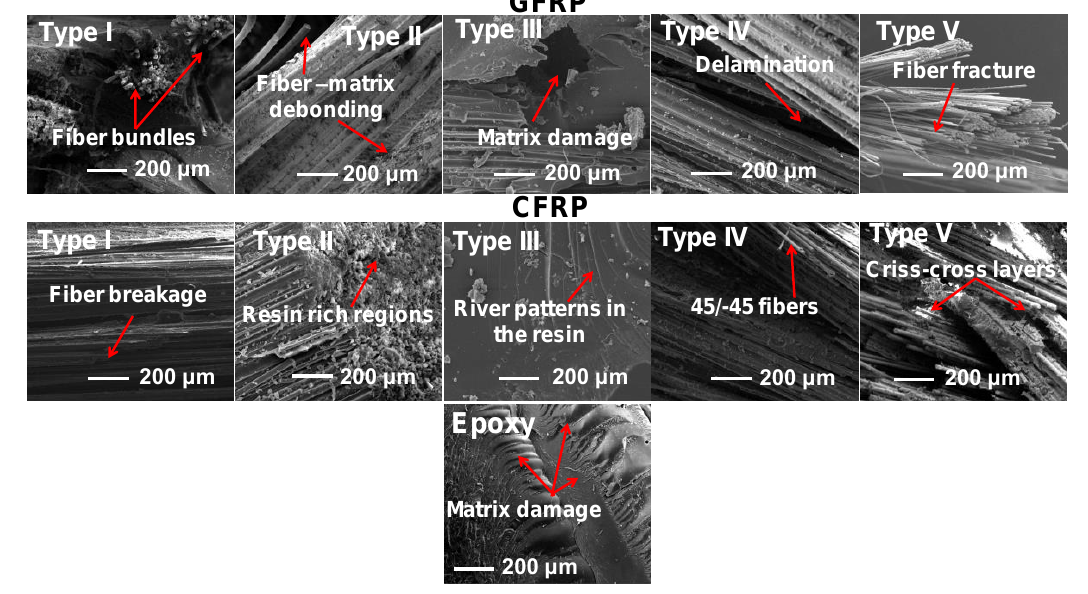
Figure 12. SEM micrographs of the fractured surface of composites and epoxy subjected to three-point bending.